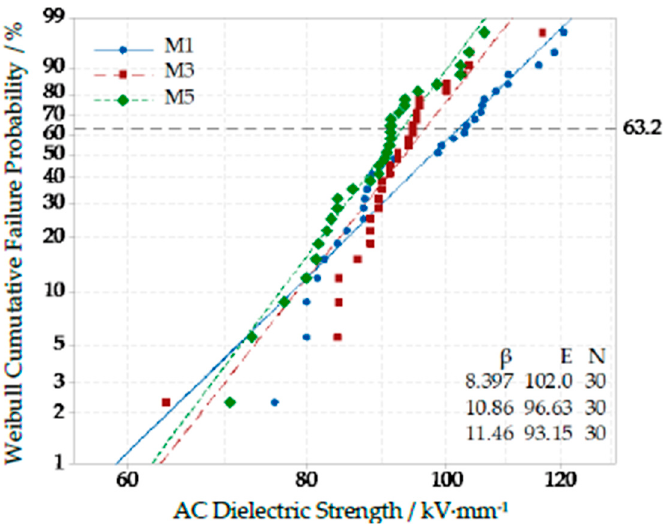
Figure 8. Weibull distribution curve of different Micro-ZnO content composites.